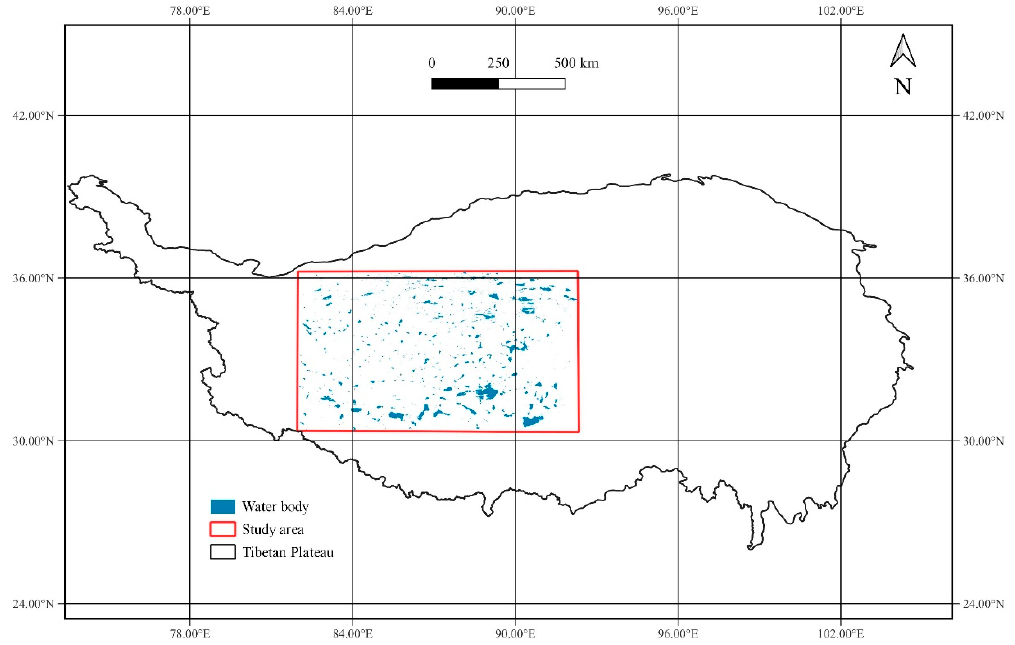
Figure 1. The location of the study area.